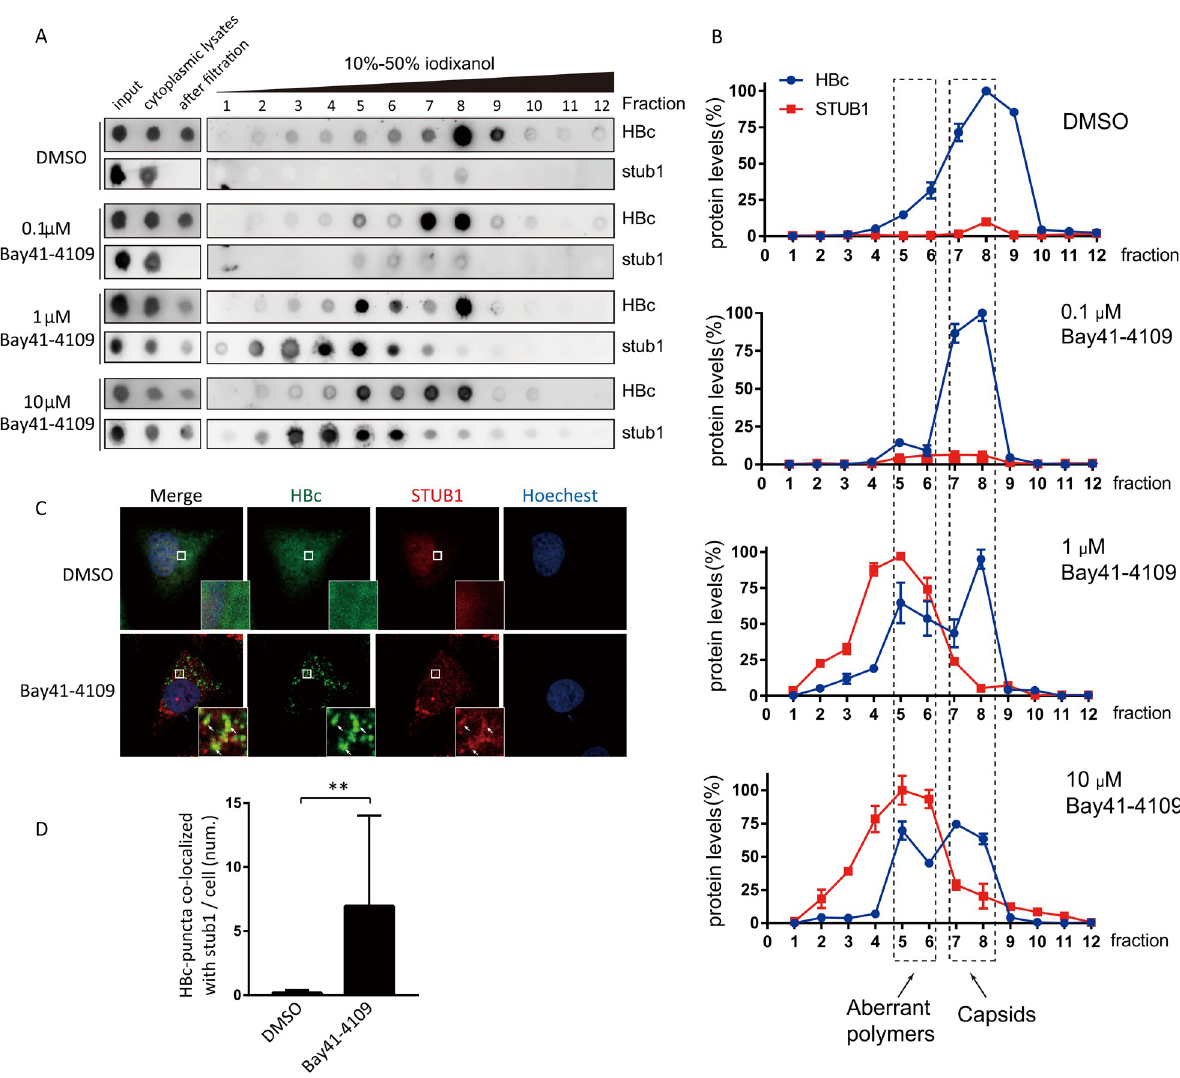
Fig 2. Co-sedimentation and co-localization of STUB1 with Bay41-4109-induced aberrant non-capsid polymers. (A, B) HepAD38 cells were treated with DMSO or increasing concentrations of Bay41-4109 (as indicated) for 36 h. Cytoplasmic lysates from each sample were condensed with a centrifugal filter (100-KDa cutoff) and subjected to iodixanol gradient ultracentrifugation. The levels of the HBc and STUB1 proteins in each fraction were then analyzed with dot blots (A), and were quantified based on two independent experiments by ImageJ (B). (C) HepAD38 cells were treated with 1 μ M Bay41-4109 or DMSO as indicated for 48 h. The cells were then immunostained for HBc (green) and stub1 (red). Nuclei were stained with Hochest33342. Areas indicated by white boxes are enlarged. Arrows point to representive co-localized sites. The scale bar is 10 μ m. (D) Quantification of the number of HBc puncta co-localized with STUB1 per cell. 100 cells were counted. The error bars indicate ± SD. �� p < 0.01, calculated by unpaired two-tailed student’s t-test.